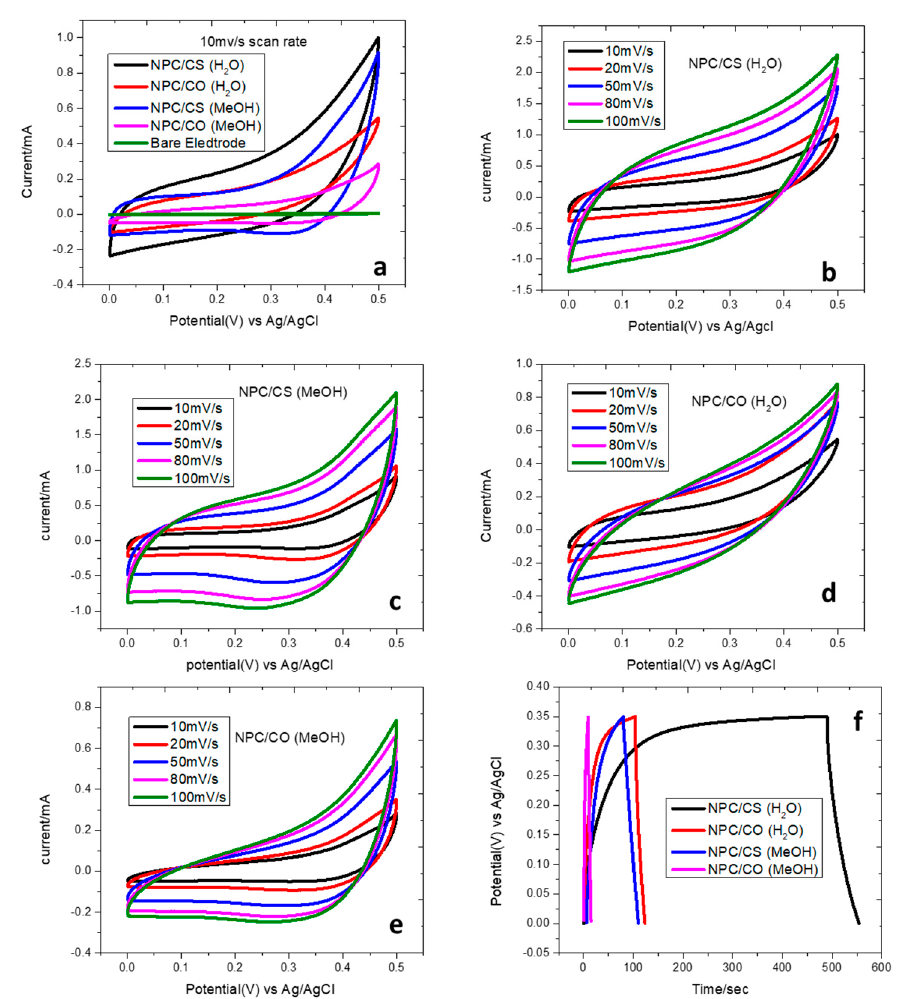
Figure 6. Electrochemical properties of the NPC/CO and NPC/CS in 2M KOH: ( a ) cyclic voltammetry at 10 mv/s scan rate ( b – e ) at different scan rates and ( f ) charge-discharge profiles at 0.01 mA/g. Table 3. Specific capacitance calculated from cyclic